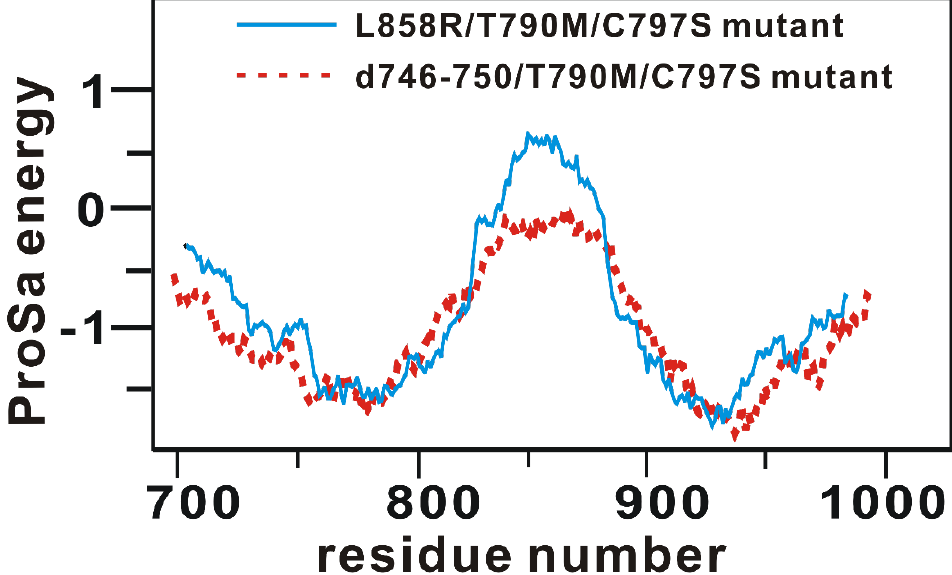
Figure 1. Comparative view of the ProSa energy profile of the homology-modeled structure of d746-750/T790M/C797S mutant and that of the template.